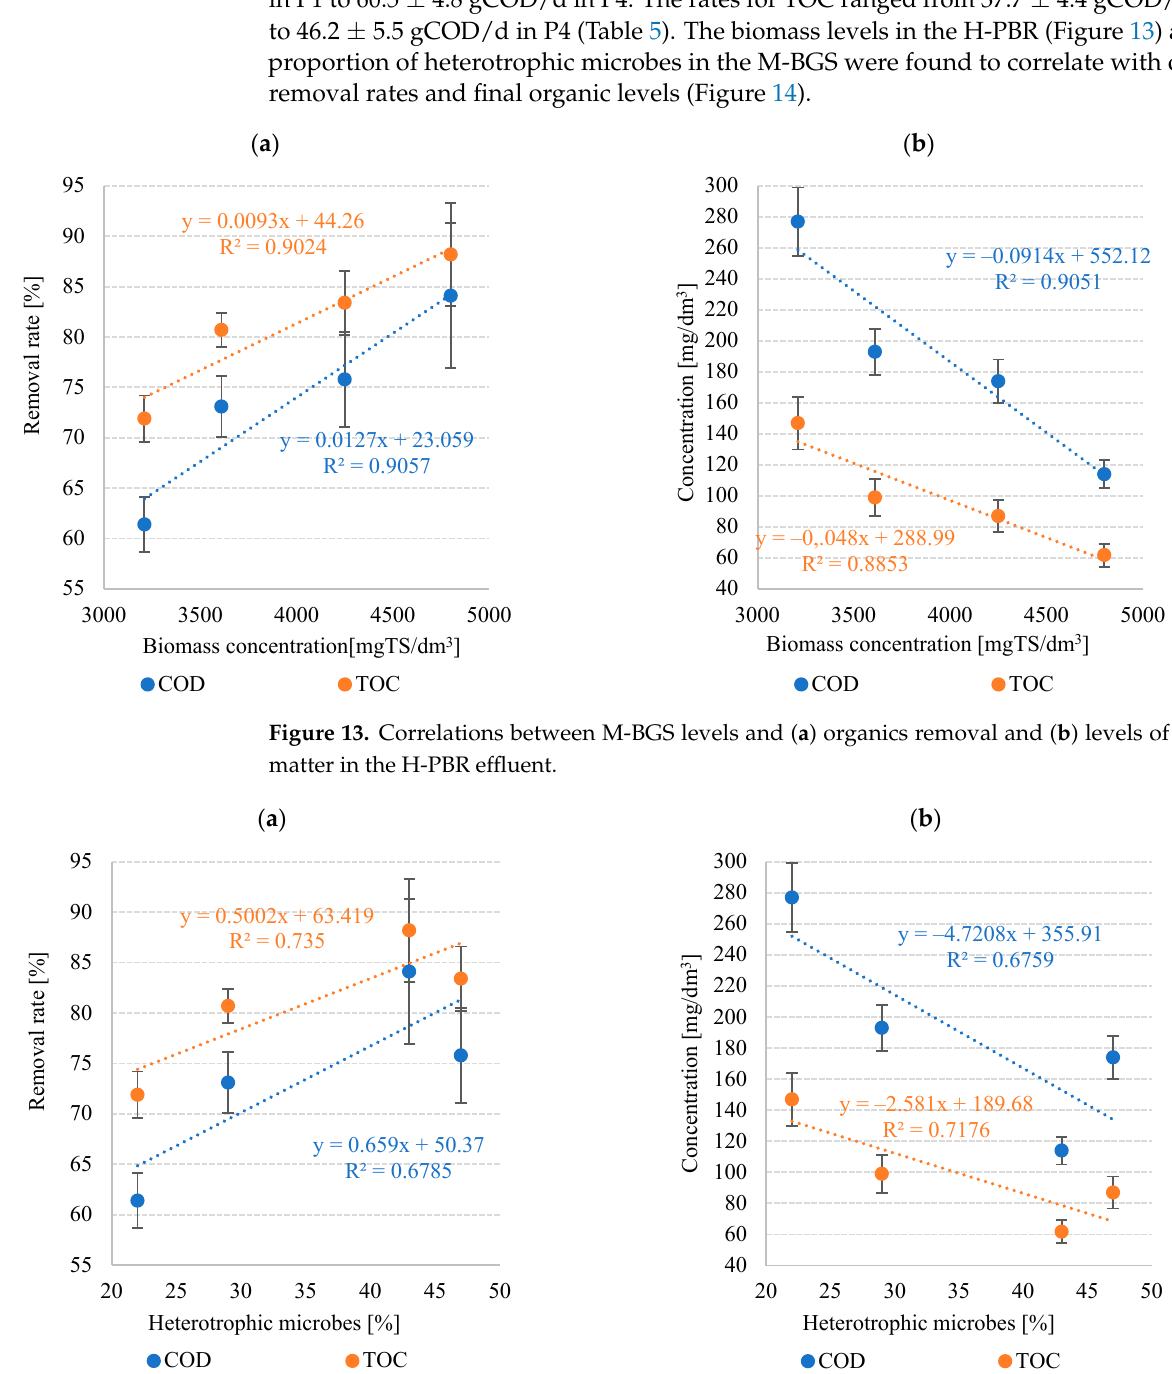
Figure 14. Correlations between the abundance of activated sludge microbes in the M-BGS and ( a ) organics removal and ( b ) levels of organic matter in the PBR effluent. The results indicate that changes in the taxonomic structure of the biomass did not significantly affect N and P removal from the LF-DSS. Final performance was similar across all phases of the experiment (Table 5). TN removal ranged from 67.2 ± 2.4% in F3 to 71.3 ± 3.1% in F1, meaning that the final levels in the effluent were 15.2 ± 1.3 mgN/dm 3 to 17.4 ± 1.6 mgN/dm 3 . The differences were not statically significant. Treatment perfor- mance for P was similar across all PBR operation phases. TP in the final effluent fell within the narrow range of 7.36 ± 0.79 mgP/dm 3 to 7.69 ± 0.82 mgP/dm 3 , whereas P-PO 4 ranged from 0.98 ± 0.23 mg/dm 3 to 1.25 ± 0.30 mg/dm 3 . Indicators of LF-DSS treatment perfor- mance (pollutant removal rate, levels in effluent, load removed and specific M-BGS bio- mass growth) are given in Table 5.